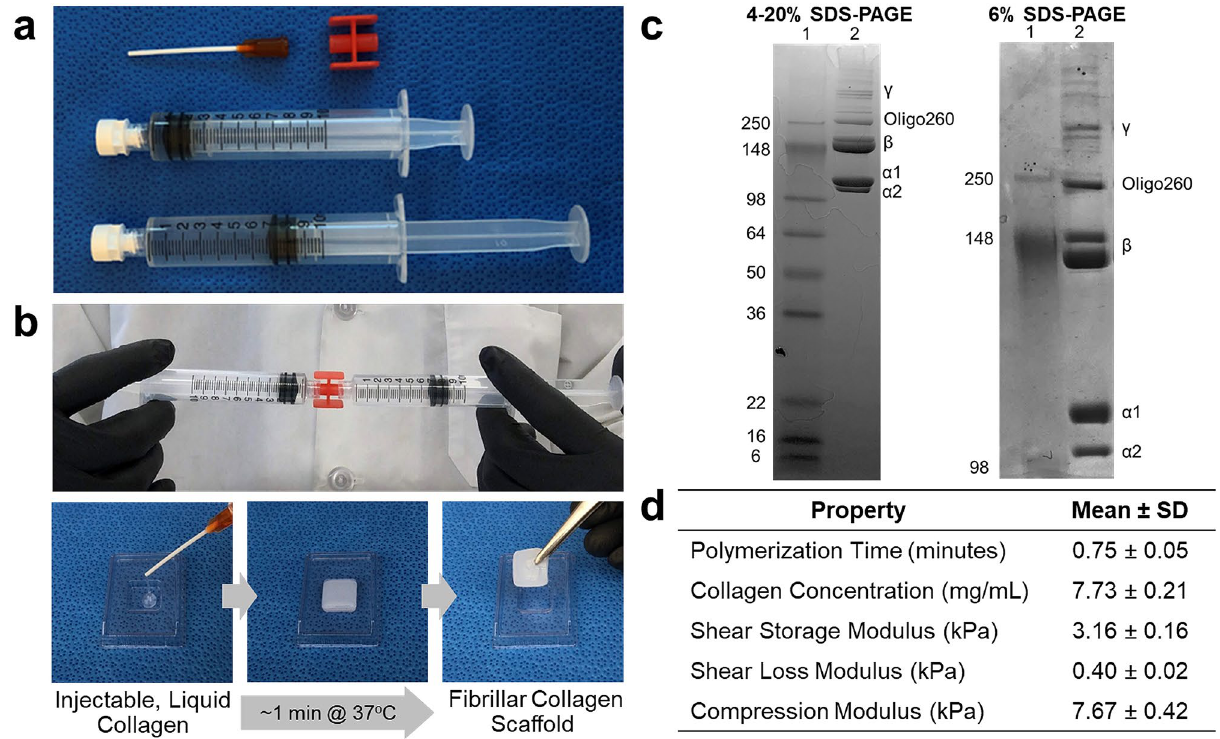
Figure 1. Purified liquid collagen forms viscoelastic fibrillar scaffold with soft tissue-like properties. ( a ) Kit consisting of syringe containing sterile type I oligomeric collagen solution, a syringe of propriety neutralization (self-assembly) buffer, a luer-lock adapter, and applicator tip. ( b ) Images showing mixing of two reagents followed by injection into a plastic mold maintained at body temperature (37 °C), where the liquid transitions into a stable, shape-retaining fibrillar collagen scaffold. ( c ) SDS–PAGE (4–20% and 6% gels) documenting purity and characteristic banding pattern of type I oligomeric collagen. Images represent full length gels and show all relevant lanes. Lane 1: molecular weight standard. Lane 2: type I oligomeric collagen. Uncropped images of the full gel length are shown in Supplementary Figure S1. ( d ) Table summarizing collagen polymerization kinetics and performance specifications (mean ± SD; N = 4, n = 6–8) of prototype collagen